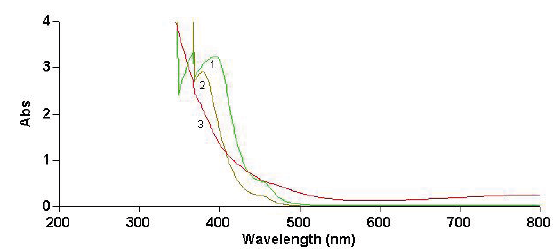
Figure 5. UV-VIS scans of sample “Precursor diluted in ratio: 1) 1:1, green line; 2) 1:2, brown line; and 3) 1:1, aged under sunlight, red line.